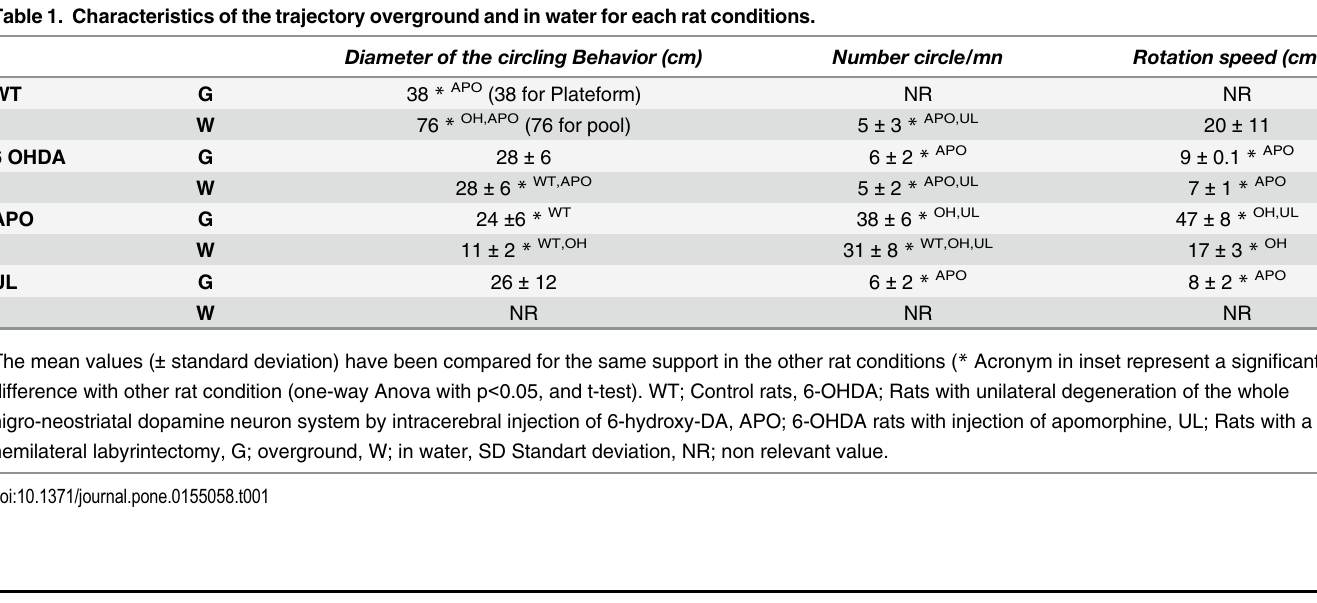
Table 1. Characteristics of the trajectory overground and in water for each rat conditions. Diameter of the circling Behavior (cm) Number circle/mn Rotation speed (cm/s) WT